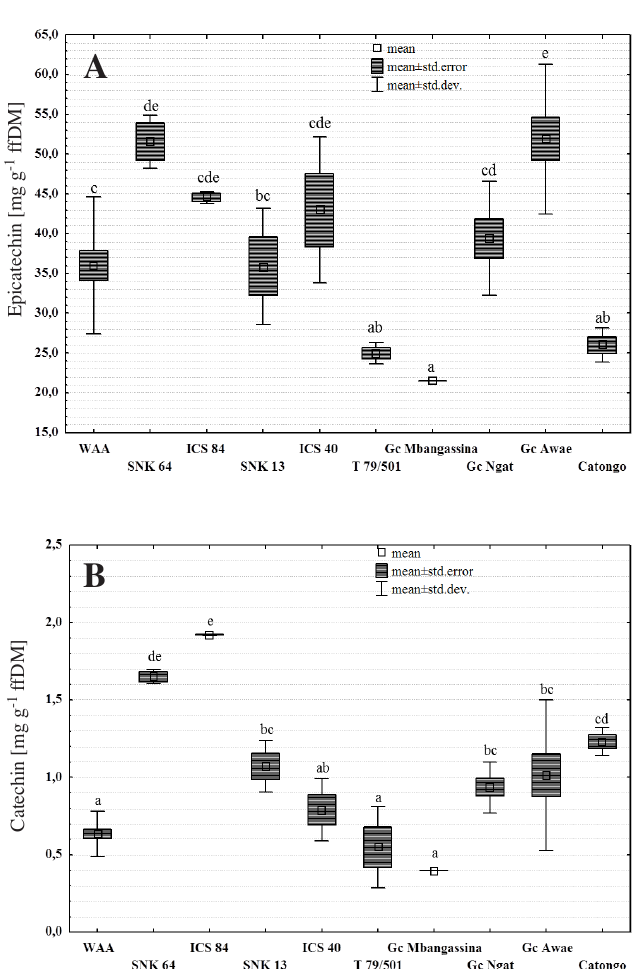
Fig. 2: Epicatechin (A) and catechin (B) content from traditional German cacao (Gc) and hybrid varieties. Milled defatted cacao seeds were extracted in methanol and polyphenol analysis was done by HPLC. Mean values (n = 6) with different letters differed significantly at P < 0.05, Post hoc Test: Fisher LSD, P < 0.05. Mean is the result of two analyses from three independents cacao